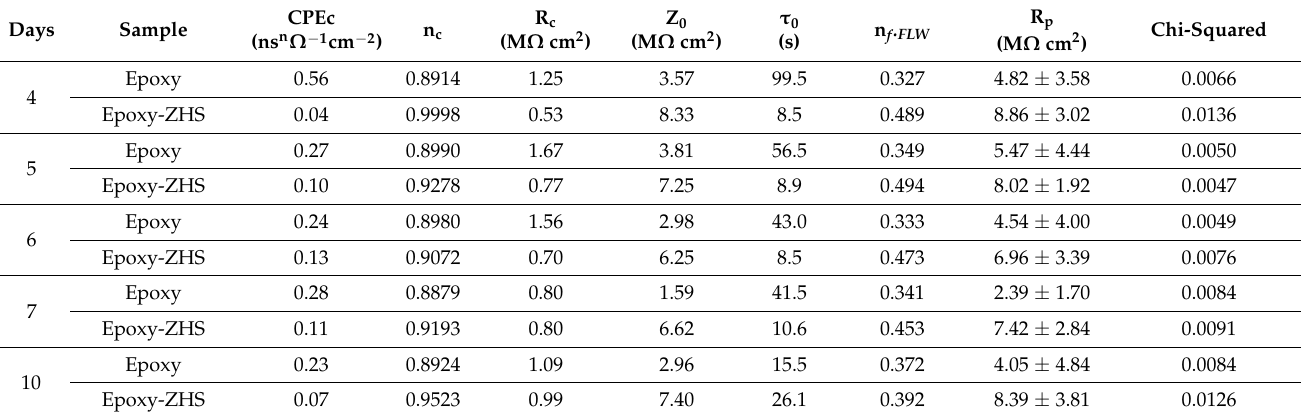
Table 1. EIS parameters of the neat and ZHS-containing epoxy coatings after different immersion